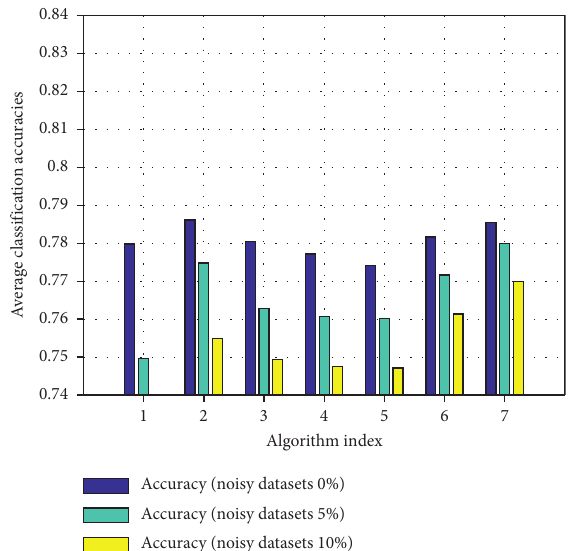
Figure 2: Comparison of robustness of different FRS models on CART.